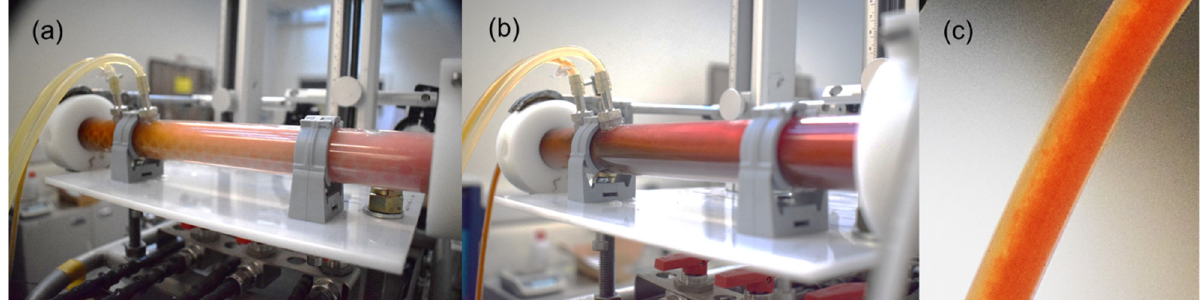
Figure 9. Example images of the agitated tubular reactor during operation at ( a ) 25 min and ( b ) 90 min (dye and adsorbent inlets are to the right of each image). Moreover, shown is ( c ) outlet flow at 90 min.